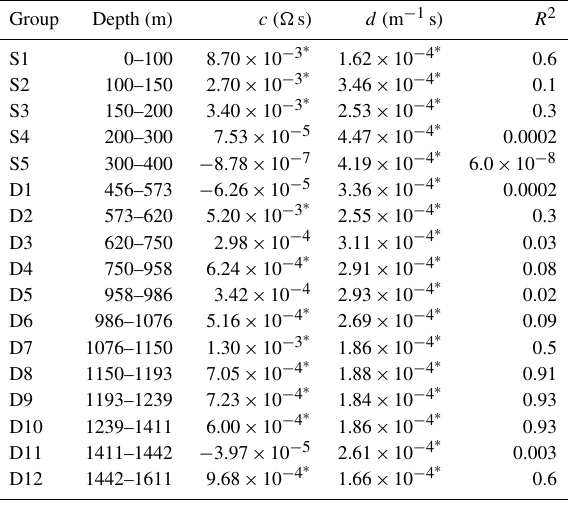
Table 2. Empirical relationship ER2: linear regression of 1 /V vs. 1 /R